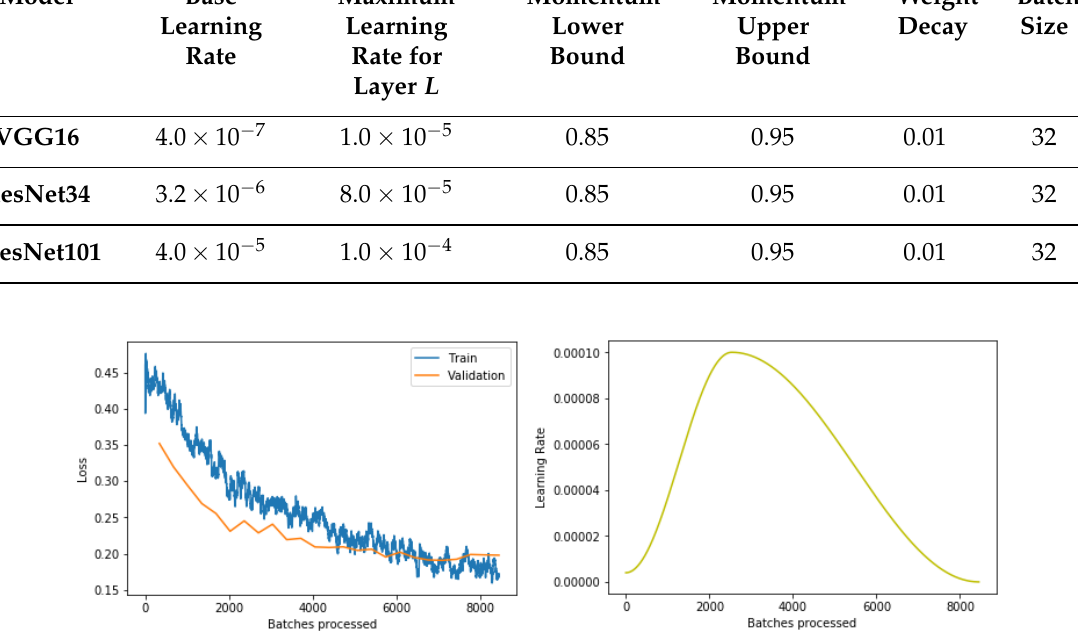
Figure 9. Fine-tuned training of ResNet101. Training loss is displayed for each processed batch and validation loss for each epoch. The cyclical learning rate throughout the training process can be seen on the